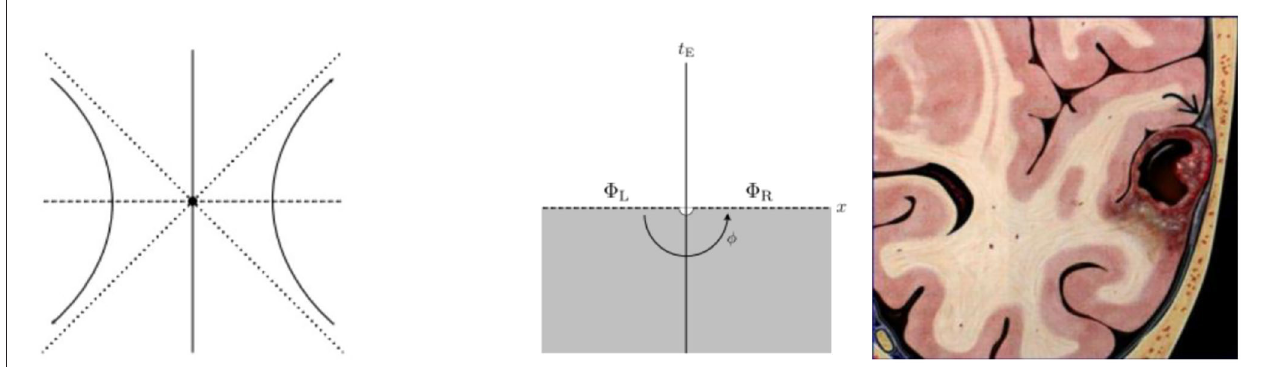
FIGURE 2 | Wormhole equations and brain tumor in bottle-neck shape. (Left) Hyperbola of angular momentum. (Middle) Hyperbolic disk. (Right) Multitype